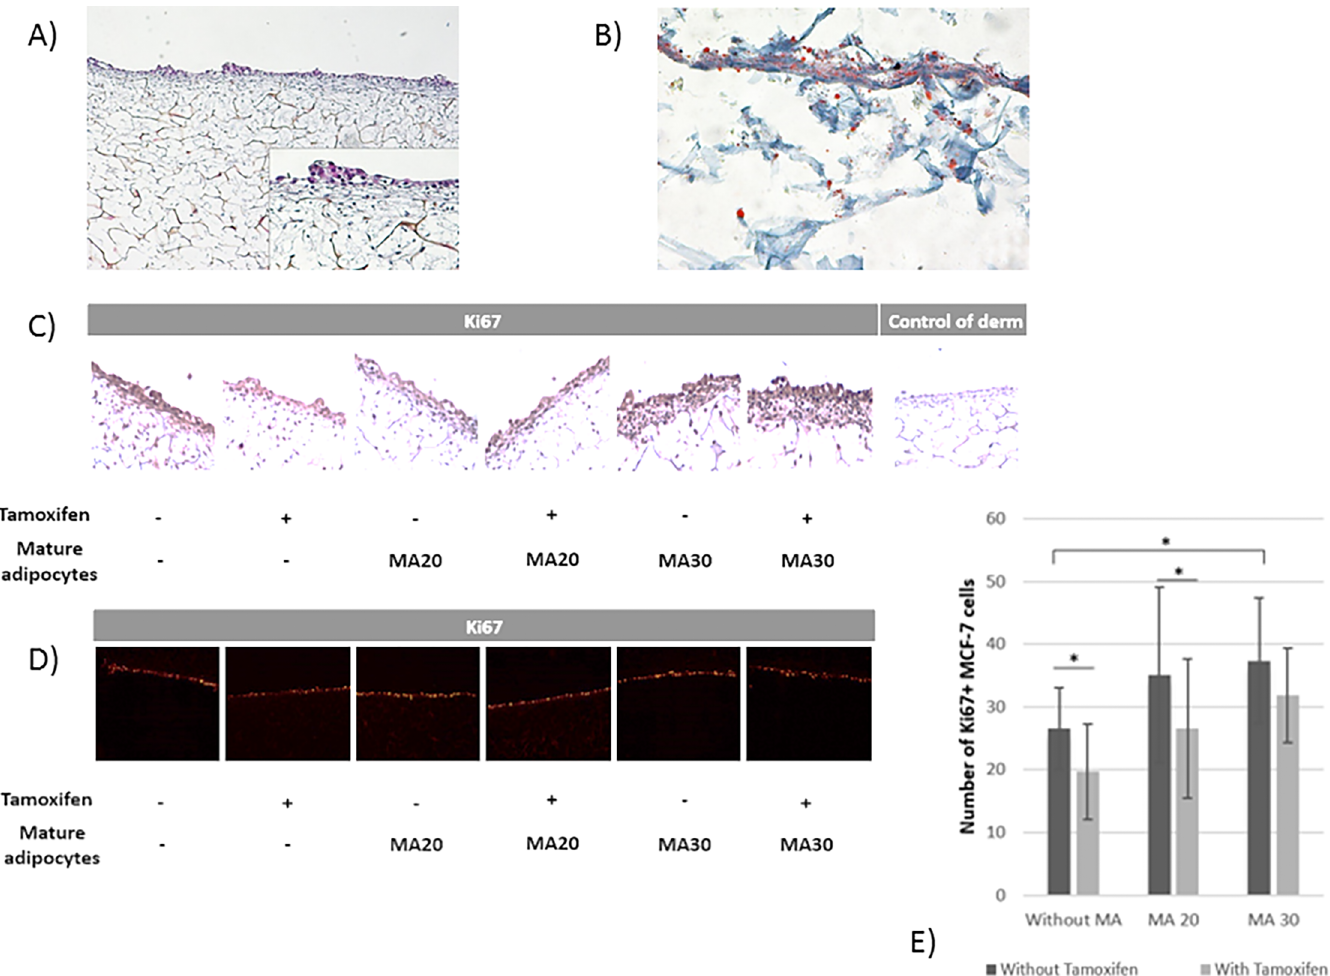
Fig 2. Tridimensional adipose mammary equivalent model. (A) Hematoxylin Phloxin Safran staining showed a pluristratified and differentiated epithelium on a connective underlying tissue made of fibroblasts surrounded by their ECM coloured in yellow in the porous scaffold. (B) Mature adipocytes were visible after Oil Red O staining coloring their vesicles in pink. (C) Ki67 immunohistochemical staining of the tridimensional adipose equivalent model using affinity-purified polyclonal biotinylated antibodies raised against Ki67 (Magnification: × 400). Positive staining appeared in brown. (D) Ki67 immunofluorescent staining of the tridimensional adipose equivalent model. Positive staining appeared in red. (E) Comparison of cellular proliferation in tridimensional adipose equivalent model with or without mature adipocytes and tamoxifen treatment.